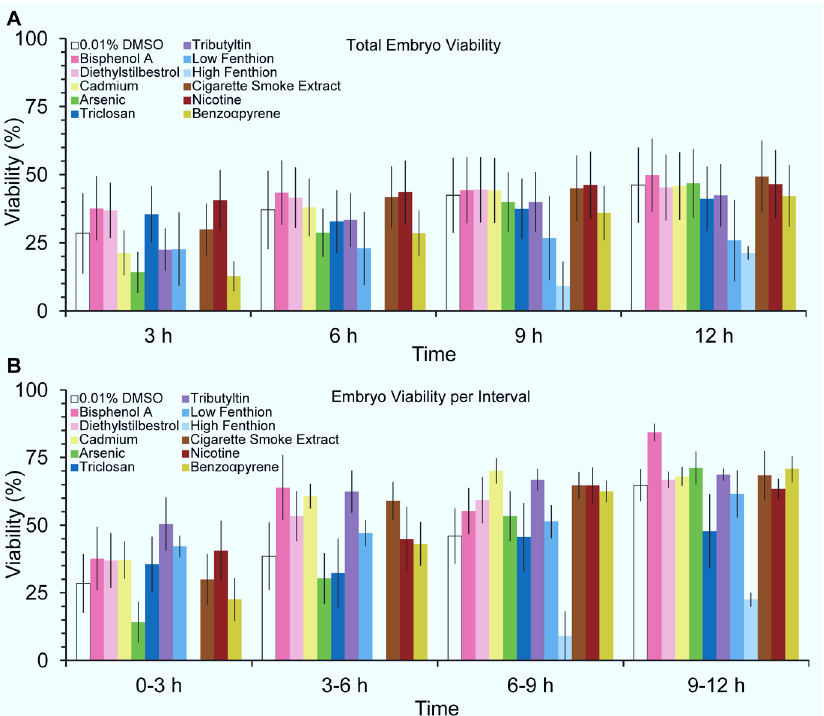
Figure 5. Effects of teratogens on embryo viability. Temporal pattern of ( A ) overall embryo viability at 3, 6, 9 and 12 hours post-exposure to teratogens and ( B ) embryo viability at 3 hours intervals. Embryo viability calculated as the ratio of hatched larvae/eggs laid X 100% (mean ± sem). Asterisks indicate P